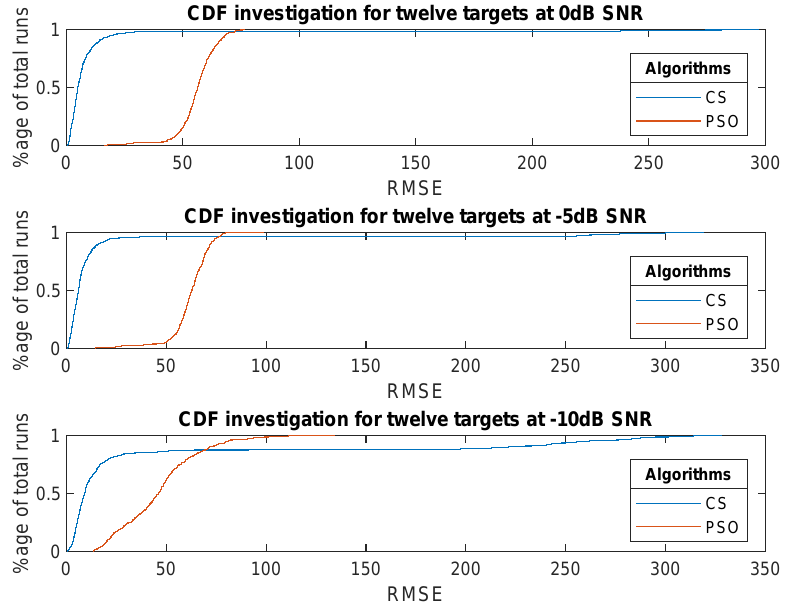
Figure 15. RMSE investigation in terms of CDF using twelve targets for various values of SNR.